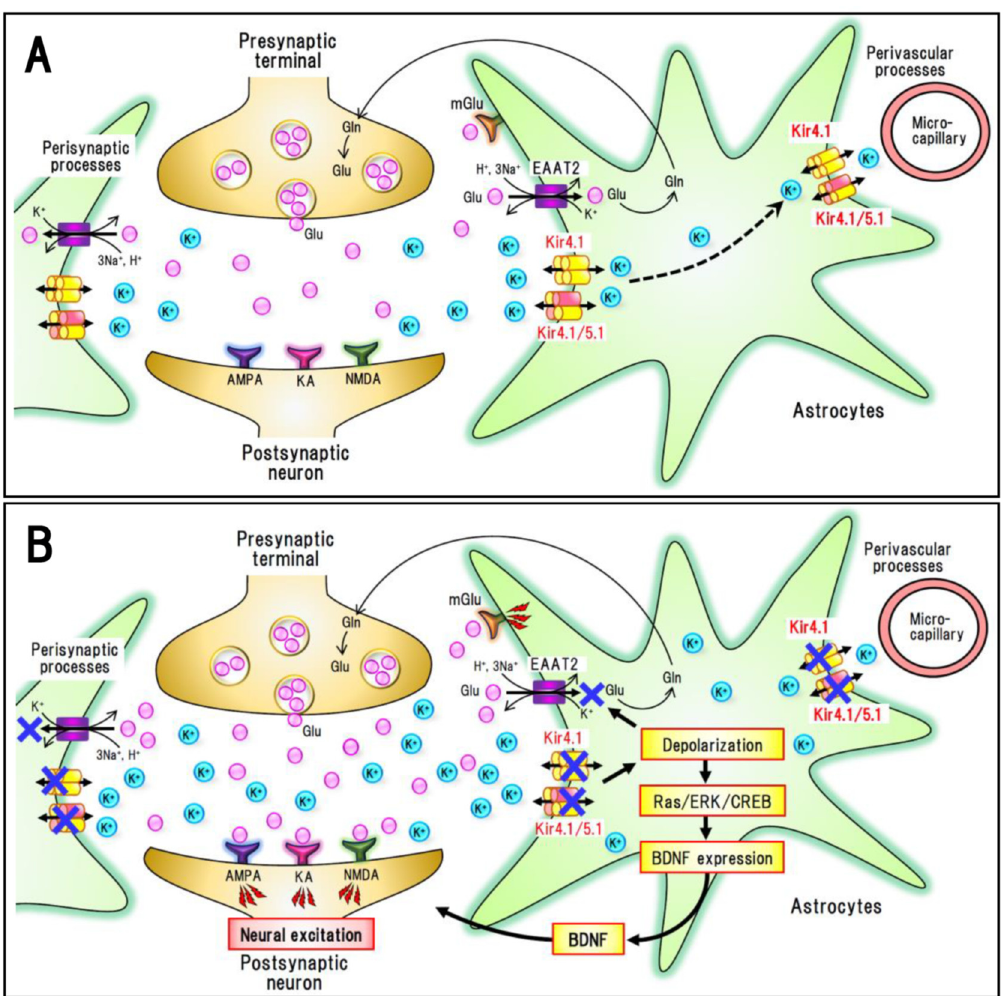
Figure 2. Diagrams illustrating the pathophysiological changes in Kir4.1 channel functions. ( A ) Synapses under normal conditions. ( B ) Synapses in disease conditions. The functions of astrocytic Kir4.1 channels are inhibited, under pathophys- iological conditions, by gene mutations, expressional suppression, or pharmacological treatments. Inhibition of Kir4.1 channels results in an elevation of extracellular K + levels in synapses. Since Kir4.1 channels play a role in maintaining the resting membrane potential of astrocytes, Kir4.1 channel blockade causes a depolarization (excitation) of astrocytes, which in turn inhibits astrocytic glutamate uptake via EAAT2. Elevated levels of extracellular K + and glutamate cause a hyper- excitation of neurons. Astrocyte excitation also promotes an increase in the expression of BDNF by activating the Res/ERK/CREB pathway, which may consequently contribute to epileptogenesis via enhancing neural connectivity, syn- aptic plasticity, and neurogenesis.